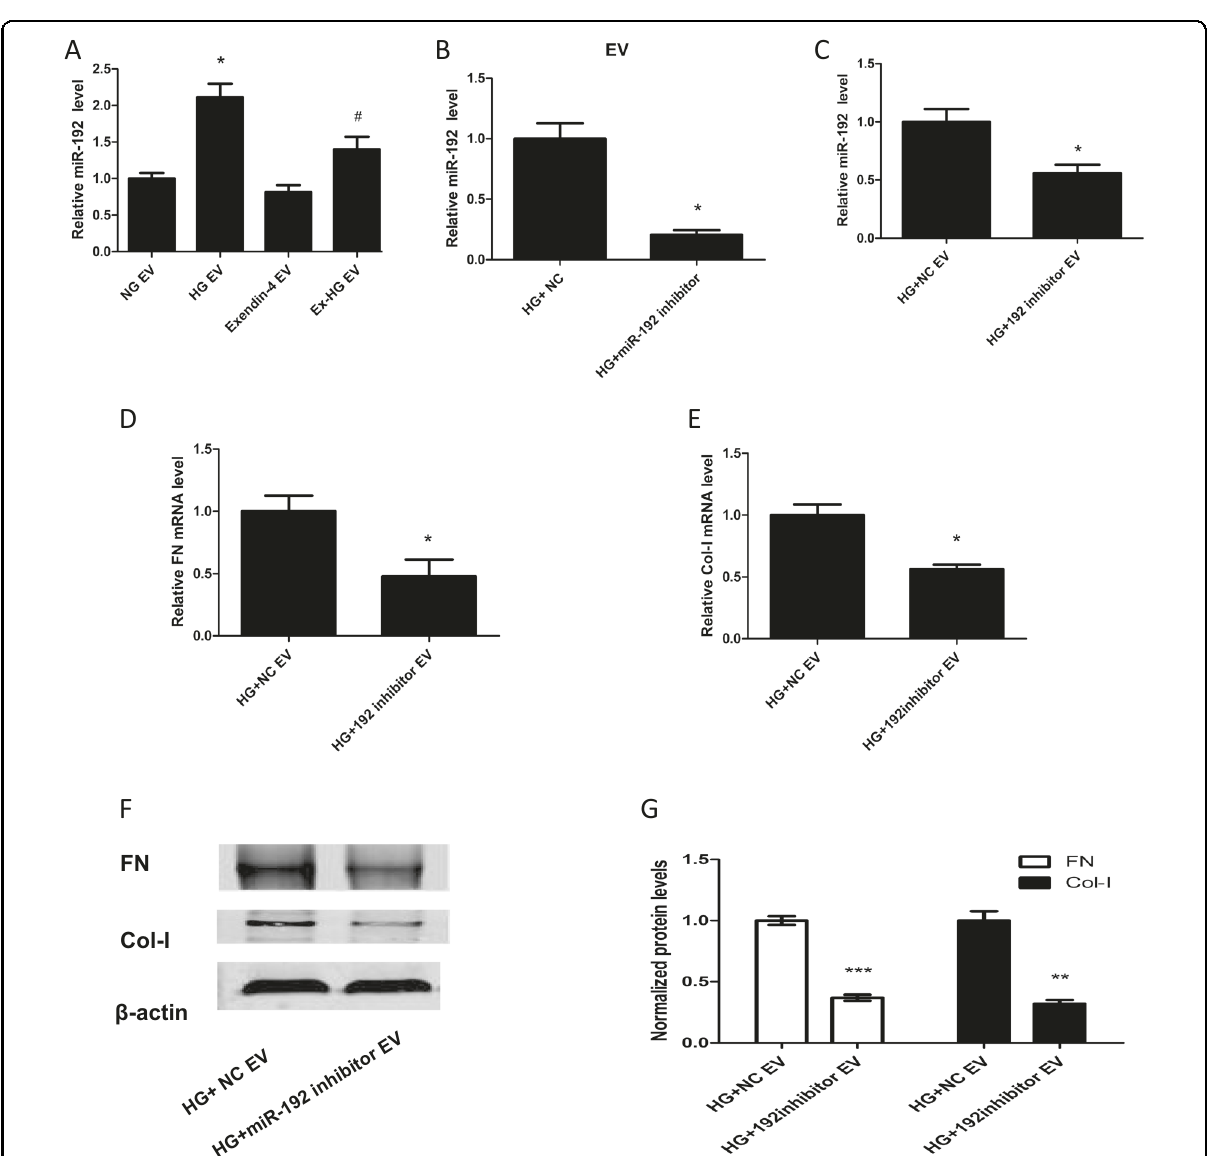
Fig. 5 miR-192 in donor-cell EVs induced fi brosis in recipient cells. a Relative expression of miR-192 in HK-2 cells after incubation with EVs derived from NG, HG, exendin-4, and Ex-HG groups for 48 h (* P < 0.05 versus the NG EV group; # P < 0.05 versus the HG EV group). b Relative expression of miR-192 in EVs derived from HK-2 cells pre-transfected with the miR-192 inhibitor or negative control (NC) and exposed to HG for 48 h (* P < 0.05 versus the HG + NC group). c – e Relative expression of miR-192, Col-I, and FN in HK-2 cells after incubation with EVs derived from HK-2 cells pre-transfected with the miR-192 inhibitor or NC and exposed to HG for 48 h. f , g Col-I and FN expression in HK-2 cells after incubation with EVs derived from HK-2 cells pre-transfected with the miR-192 inhibitor or NC and exposed to HG for 48 h was analyzed by western blot (* P < 0.05 and *** P < 0.001 versus the HG + NC EV